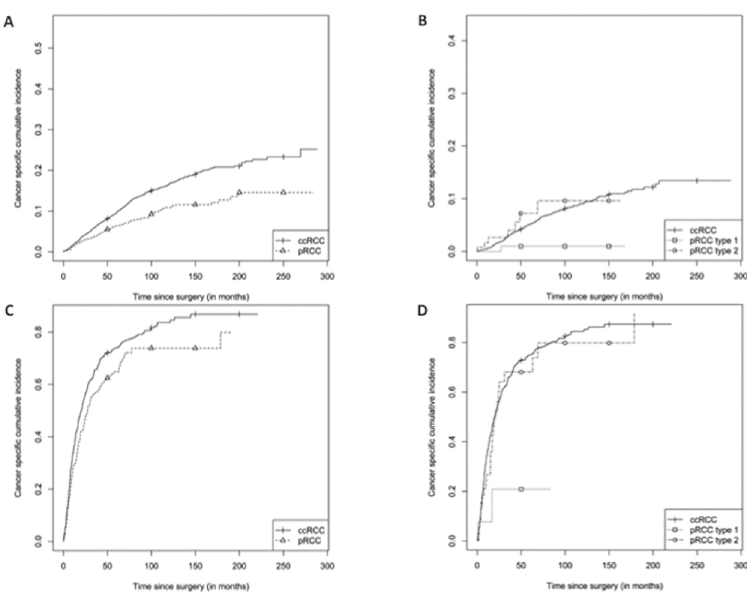
Fig 1. Cumulative incidence curves for cancer-specific mortality. A) Non-metastatic disease,papillary renal cell carcinoma(pRCC)versus clear cell renal cell carcinoma(ccRCC); B) Non-metastatic disease, pRCC subtypes (type 1 and type 2) versus ccRCC; C) Metastatic disease,pRCC versus ccRCC; D) Metastatic disease,pRCC subtypes (type 1 and type 2) versus ccRCC.